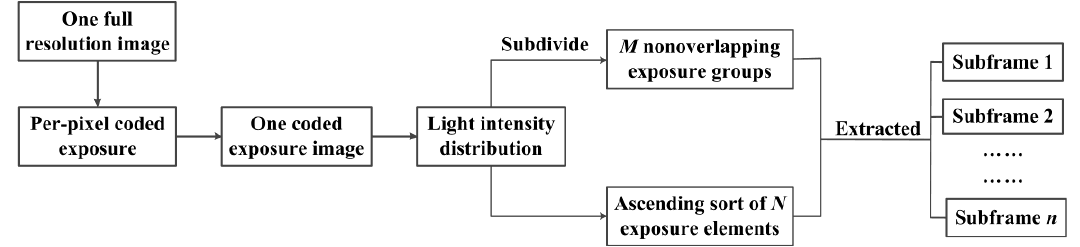
Figure 6. Flowchart of extraction of subframes.